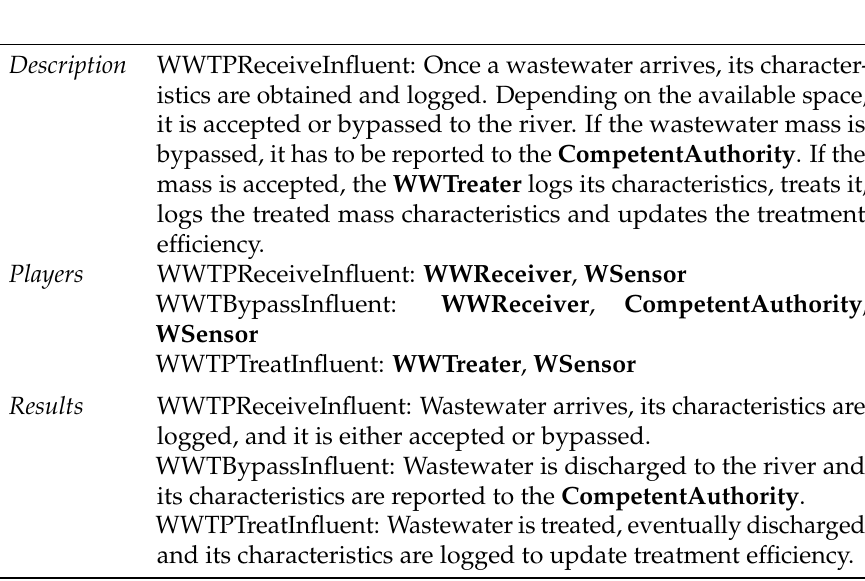
Figure A6. Landmark patterns for WWTP influent treatment. Both diagrams show how wastewater is processed in a WWTP. The left diagram shows the treatment process carried out by WWTP agent: the influent is treated and the effluent characteristics and process efficiency are logged. The right diagram shows how wastewater is bypassed and directly thrown to the river; such a bypass has to be reported to the Competent